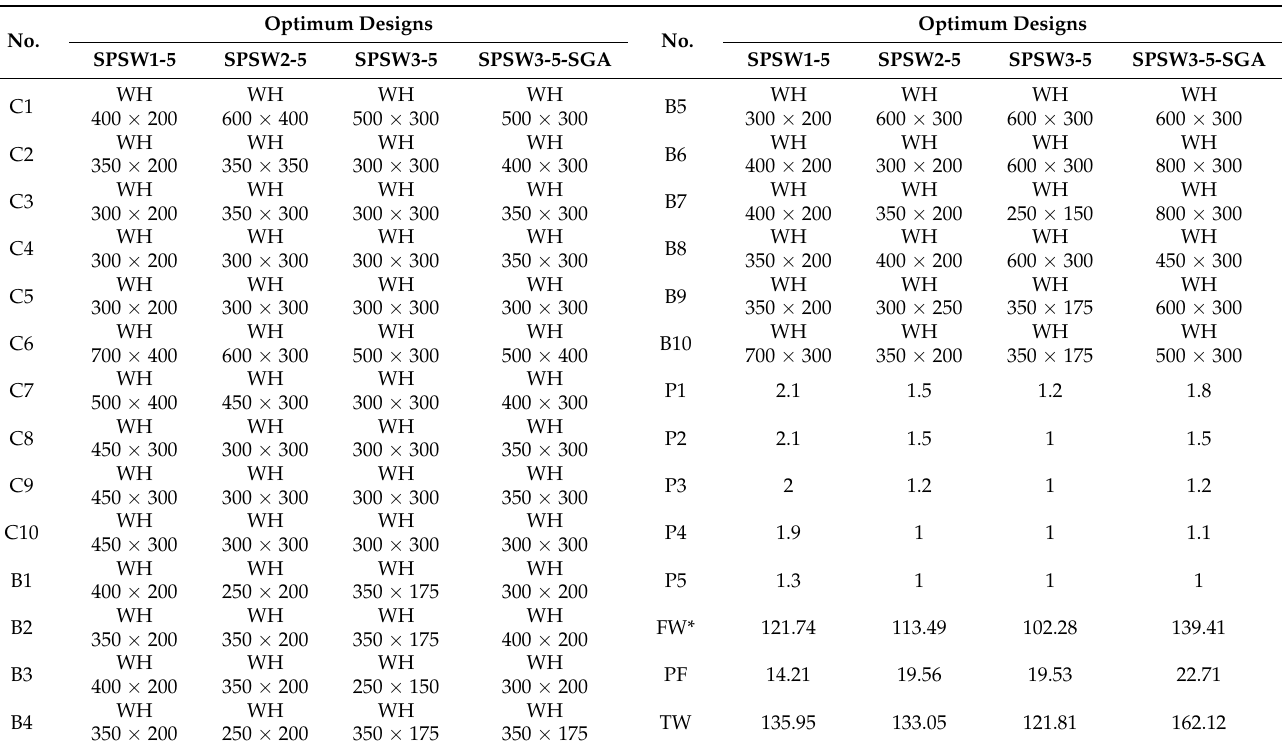
Table 5. Optimum designs of SPSW1-5, SPSW2-5, SPSW3-5, and SPSW3-5-SGA.